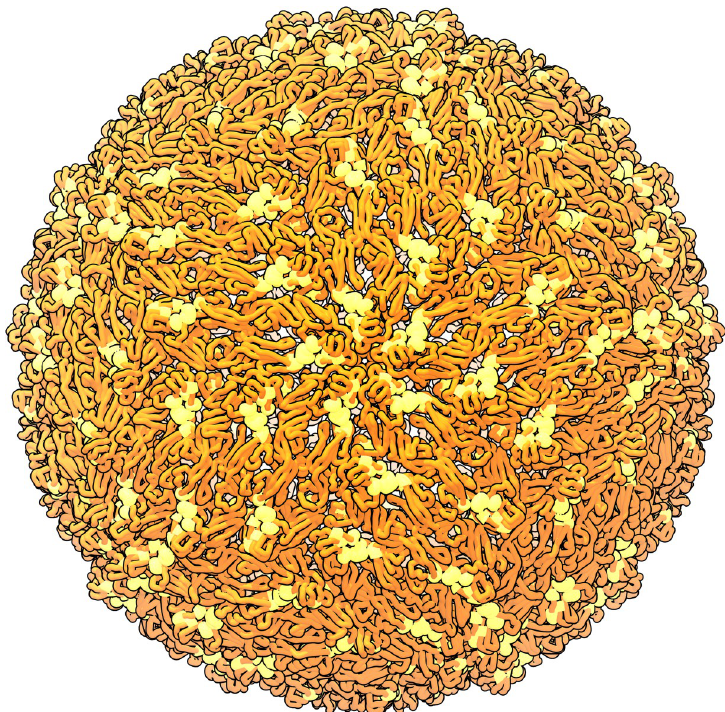
Fig 4. Conserved epitope prediction demonstration. Predicted conserved epitopes are represented in yellow on the ZIKV cryo-EM reconstruction backbone (red) (PDB ID: 5IRE) [8]. The cryo-EM reconstruction is shown with the five-fold rotational icosahedral symmetry axis coming out of the figure